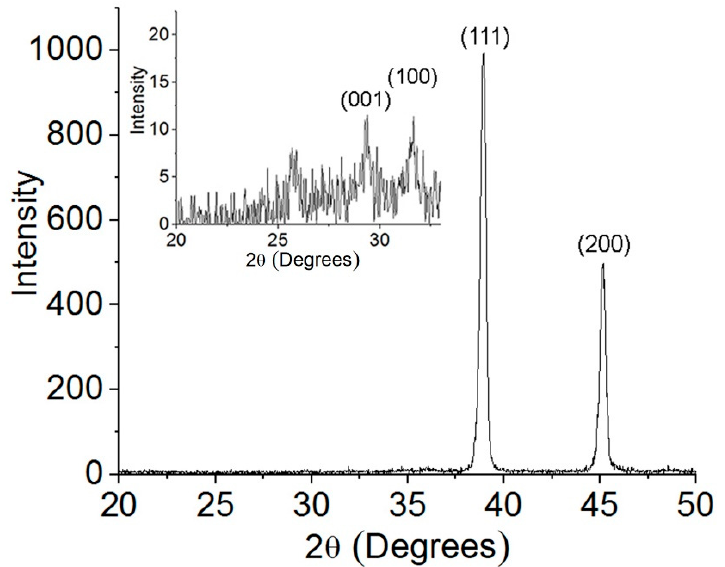
Figure 4. XRD pattern of Al/MoB 2 composite pellet after sintering. The inset displays a close-up indicating reflections from the MoB 2 crystallographic planes [15].